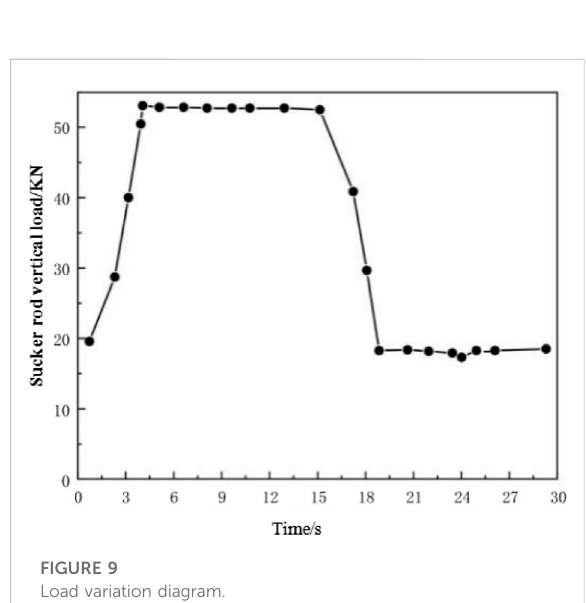
FIGURE 9 Load variation